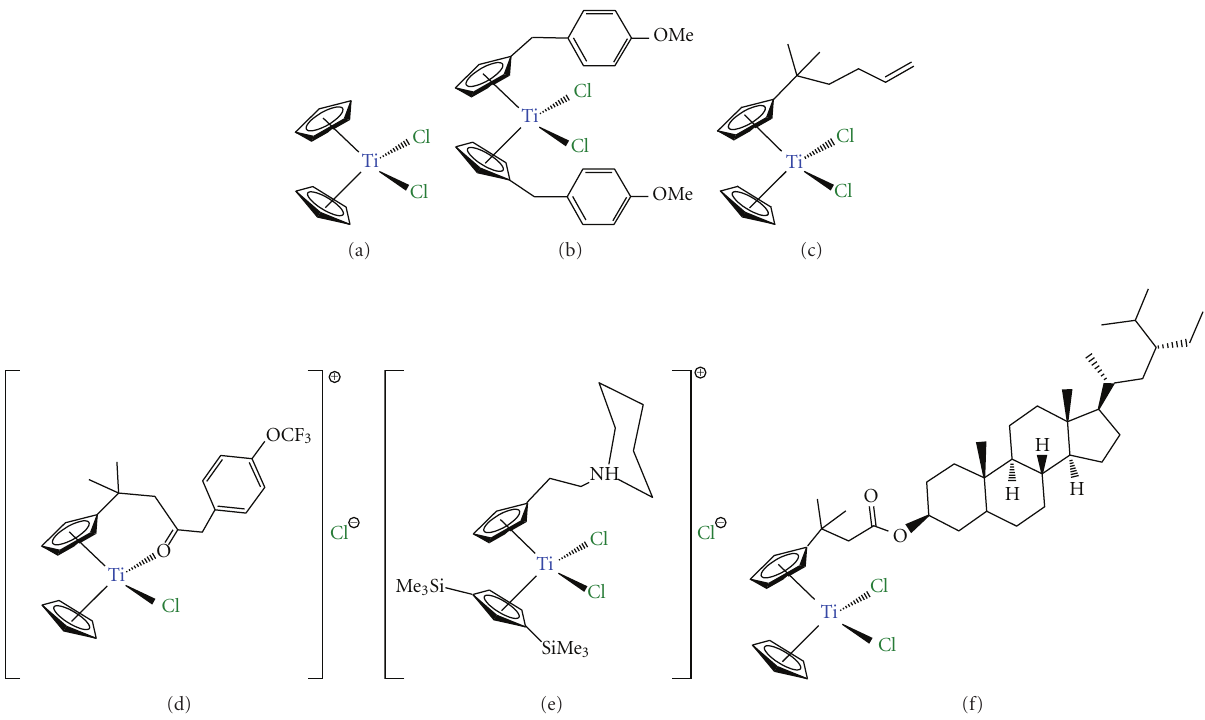
Figure 5: Titanocene derivatives used in preclinical and clinical trials: (a) titanocene dichloride; (b) titanocene-Y; (c) alkenyl-substituted titanocene derivative; (d) titanocenyl complex; (e) titanocene derivative with alkylammonium substituents; (f) steroid-functionalized titanocene